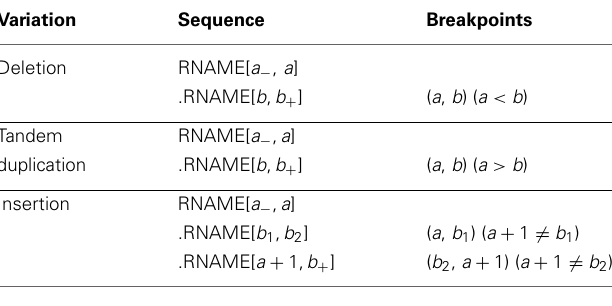
Table 1 | Types of CNVs and their breakpoints.